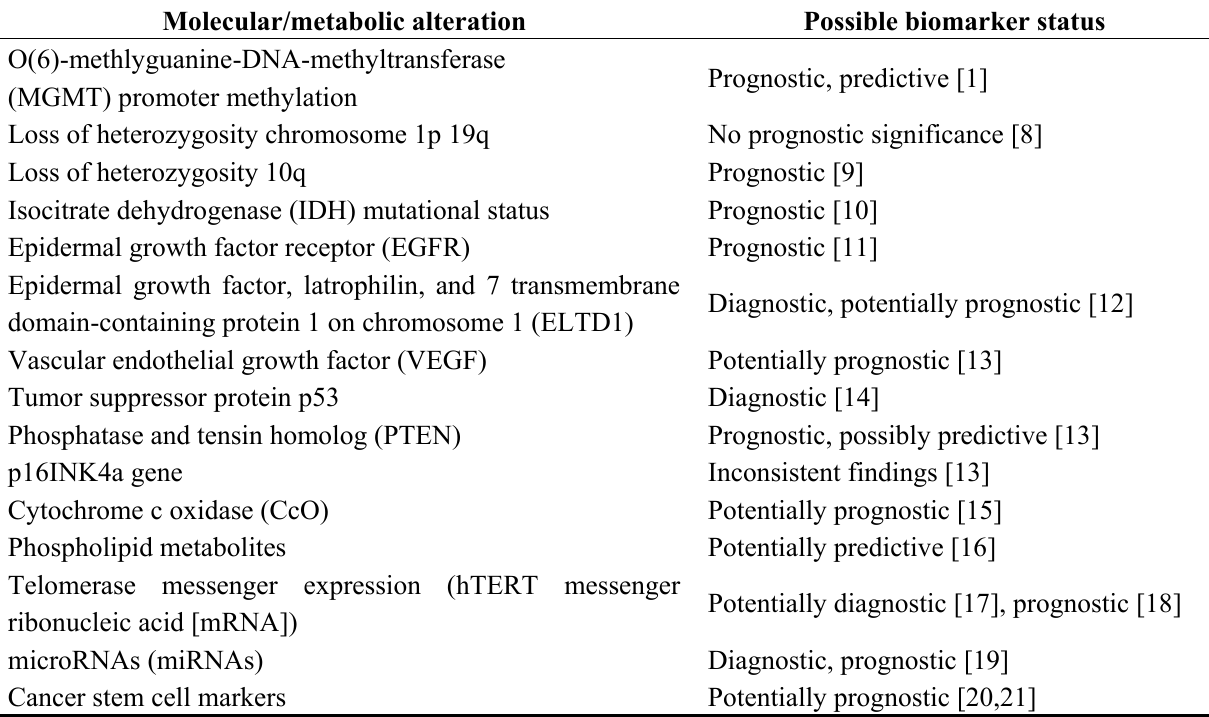
Table 2. Molecular and metabolic alterations in GBM and their potential biomarker